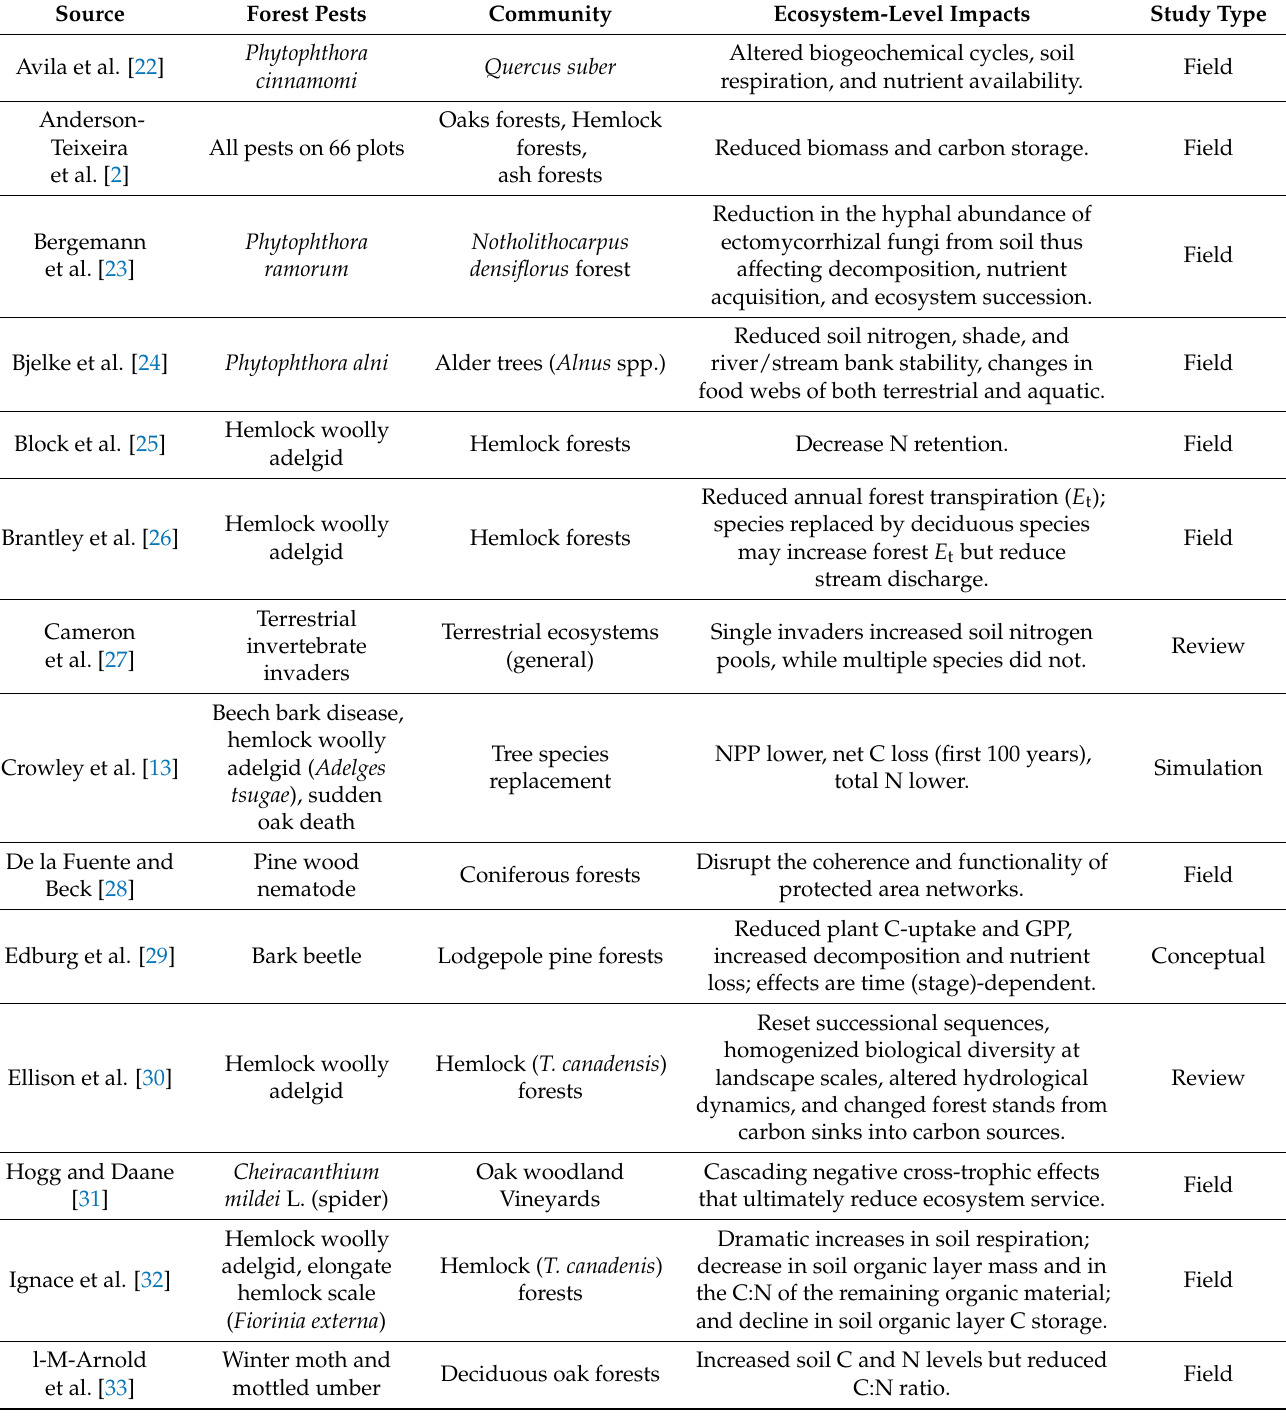
Table 1. Examples of exotic pests posing significant impacts on ecosystem functions and